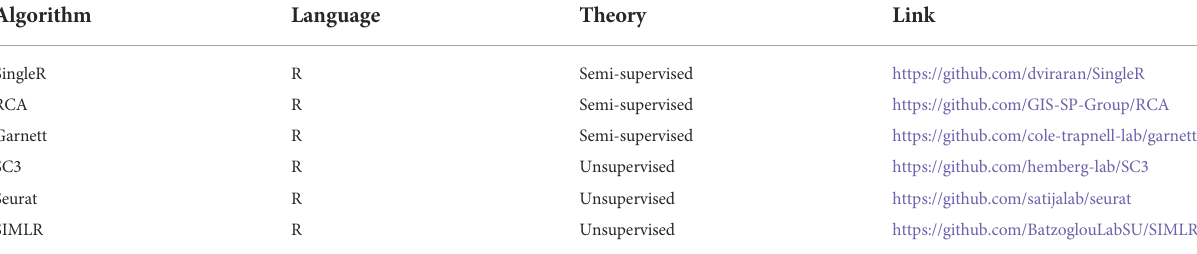
TABLE 2 Summary of the compared baseline